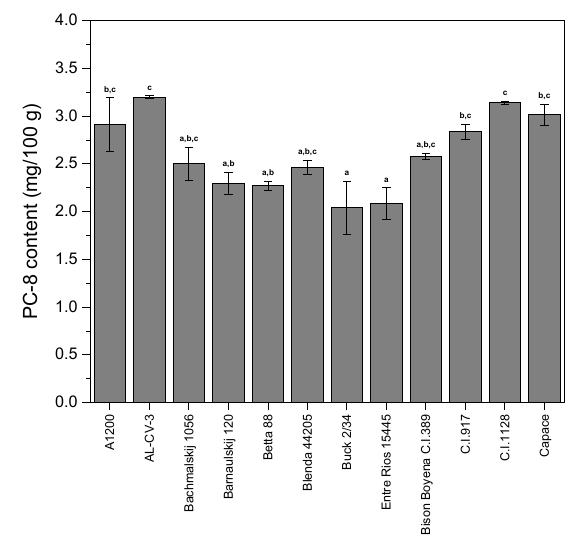
Fig. 4 Plastochromanol-8 (PC-8) content in worldwide ac- cessions of flax (Group II). Different letters indicate significant differences (Tukey’s HSD multiple comparison test, α =